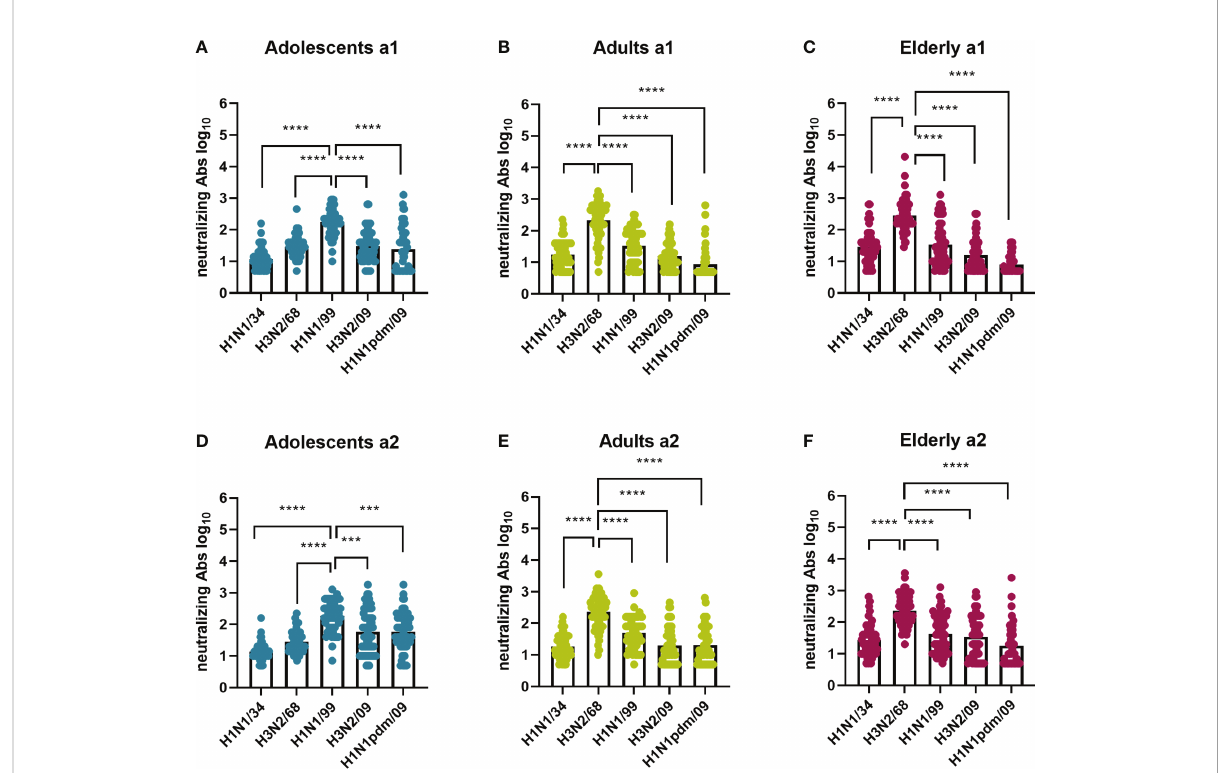
FIGURE 3 In fl uenza virus strain-related differences in neutralizing antibody titers per age cohort. Sera collected at 2 time points (a1 and a2) from adolescents (A, D) , adults (B, E) , and elderly (C, F) , 60 per age cohort, were assessed for virus neutralizing antibodies against 5 historic in fl uenza virus strains: H1N1/34, H3N2/68, H1N1/99, H3N2/09, H1N1 pdm09. For each assessment and age cohort data were analyzed using Friedman test followed by Dunn ’ s post-hoc test for multiple comparison. ***P ≤ 0.001; ****P ≤